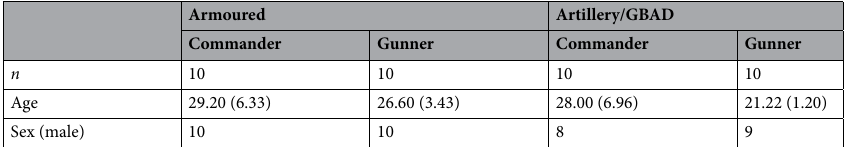
Table 1. Sample size and demographic information from the armoured and artillery samples. Standard deviation for age is presented in